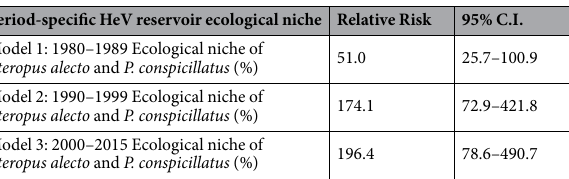
Table 2. Unadjusted relative risks and 95% confidence intervals for the associations between Hendra virus spillover incidents and the period-specific ecological niches of natural Hendra virus reservoirs (P. alecto and